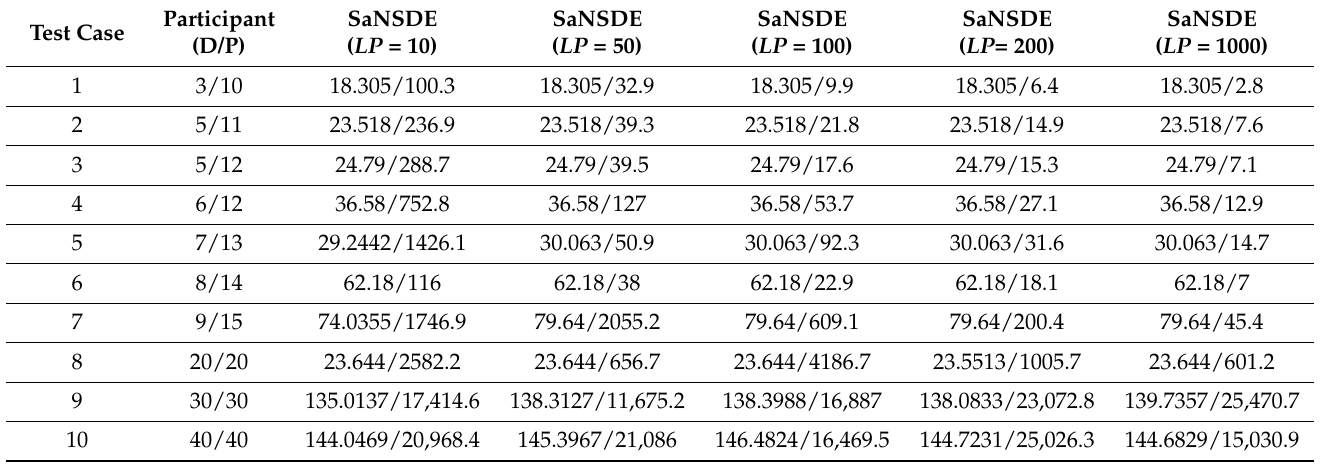
Table 17. Average fitness values and average number of generations for SaNSDE with algorithmic parameter LP to 10, 50, 100, 200 and